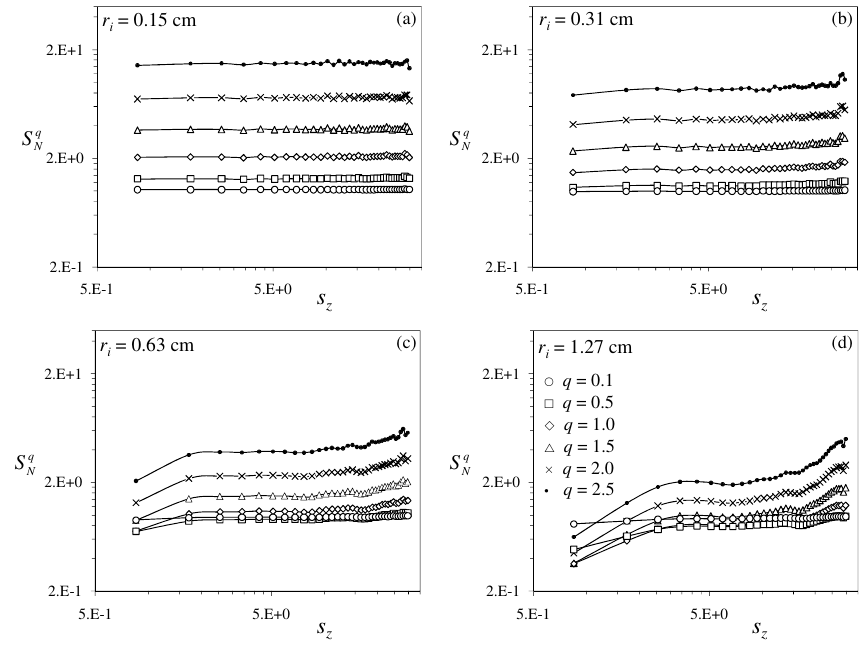
Fig. 11. Sample structure functions of absolute increments of various orders q versus lag in z direction and (a) r i =0.15cm, (b) r i =0.31cm, (c) r i =0.63cm, (d) r i =1.27cm. Figure 12